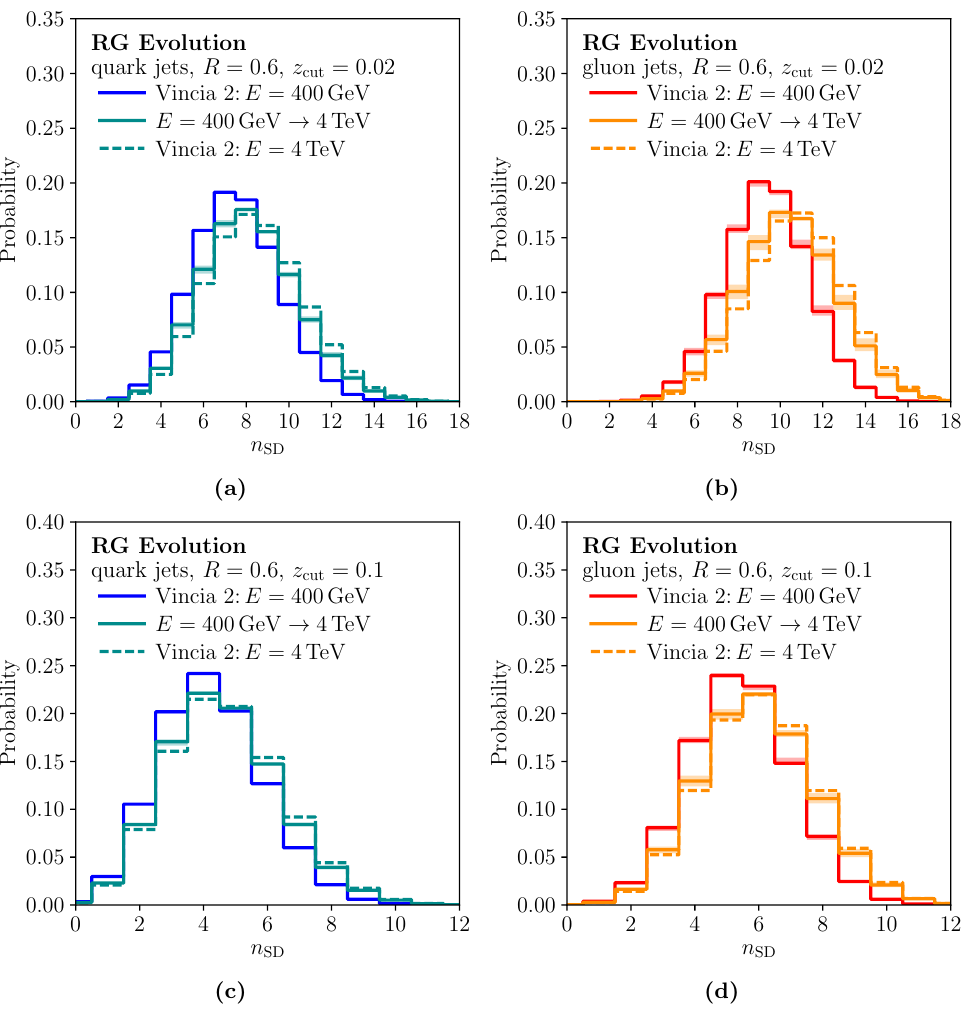
Figure 16. RG evolution of the collinear-unsafe soft drop multiplicity for (left column) the quark singlet GFF and (right column) the gluon GFF. Shown are the results for (top row) z cut = 0 : 02 and (bottom row) z cut = 0 : 1, taking distributions extracted from Vincia at a low scale and evolving them to a higher scale. The uncertainties in the evolved distributions come from varying the jet radius used for GFF extraction and the (cid:22) scale for the RG